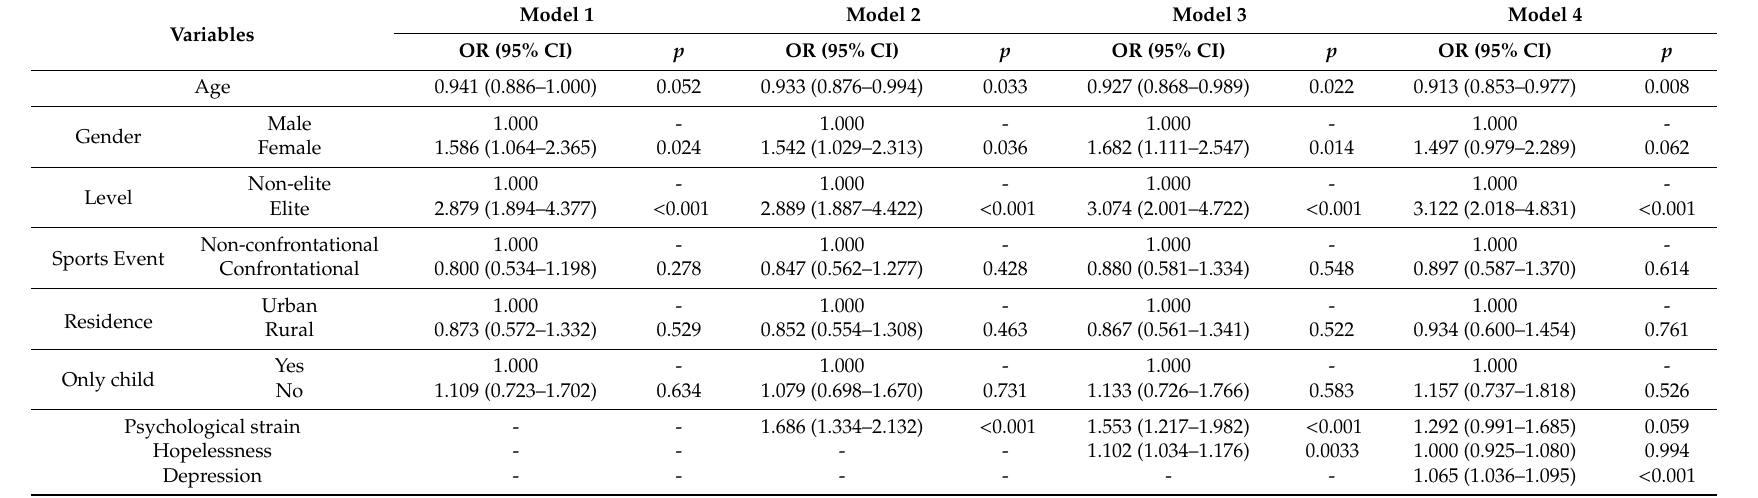
Table 3. Risk of suicidal ideation among athletes by multivariate logistic